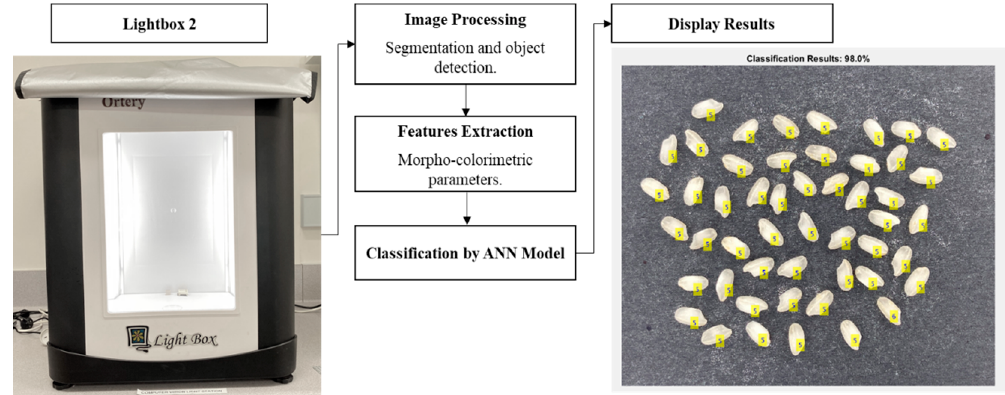
Figure 6. Flow diagram of the rice classification using computer vision and machine learning analysis. ANN = artificial neural network.